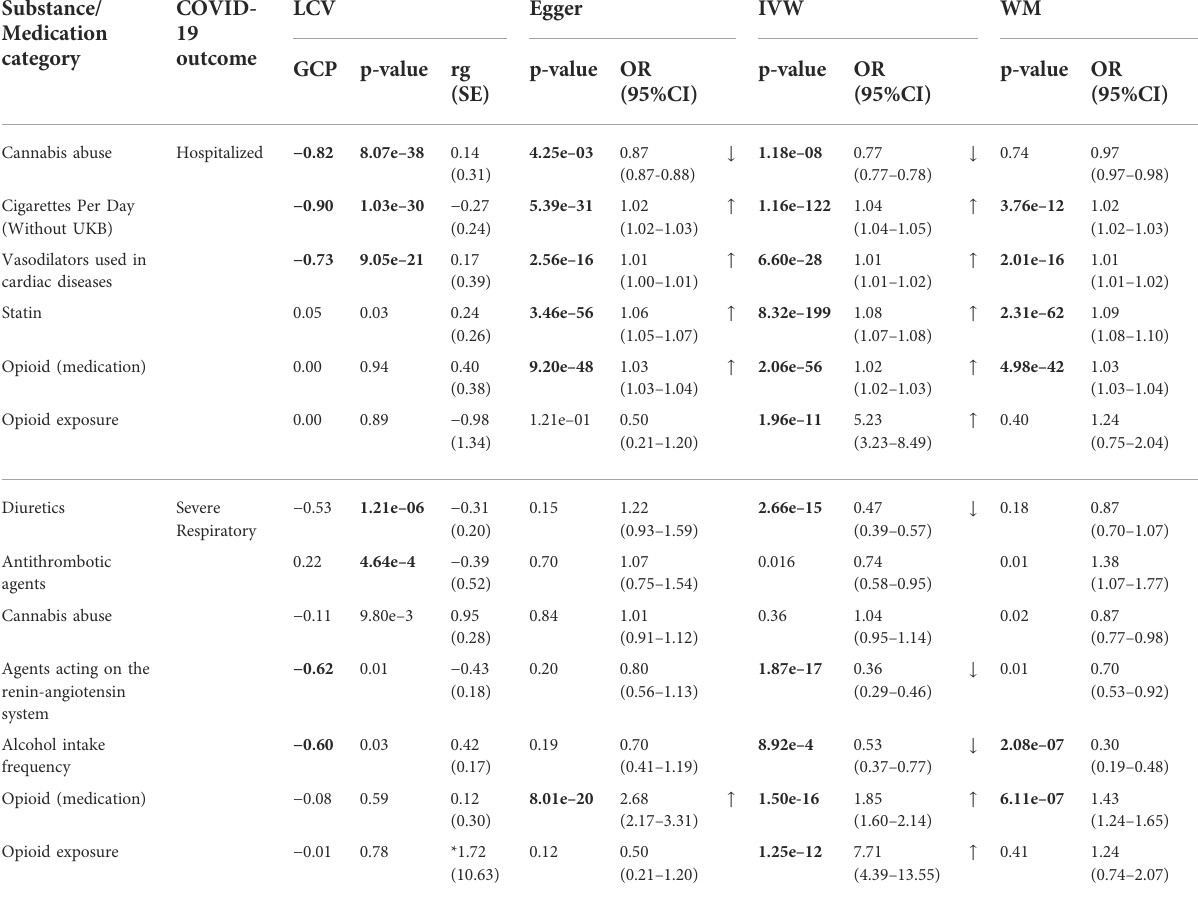
TABLE 1 Summary of MR results for causal relationship between substance/medication traits (exposure) and COVID-19 adverse